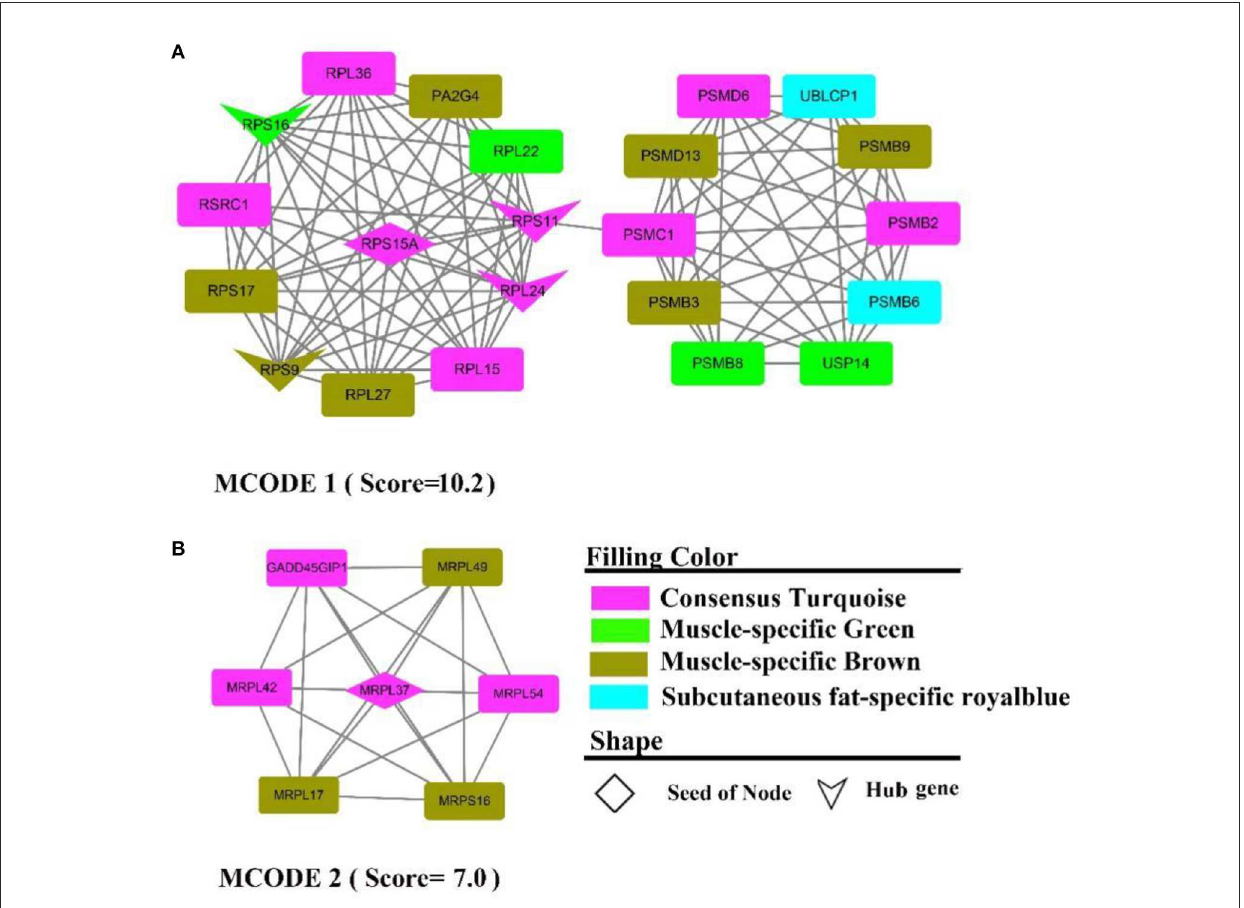
FIGURE9 PPI and hub gene analysis for genes in MF regulatory axis. The color and shape represented gene source and gene type, respectively.